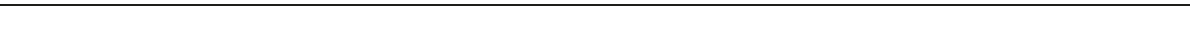
Fig. 5 Inhibition of HDAC5 promotes CXCR4 transcription. a CXCR4 mRNA levels in M344- or LMK235-treated human CB CD34 + cells, relative to vehicle- treated cells, as assessed by quantitative RT-PCR. None indicates the group without any treatment. Data pooled from two independent experiments are shown ( n = 6, one-way ANOVA, *** p < 0.001). b Human CB CD34 + cells were transfected with scrambled control or HDAC5 shRNA